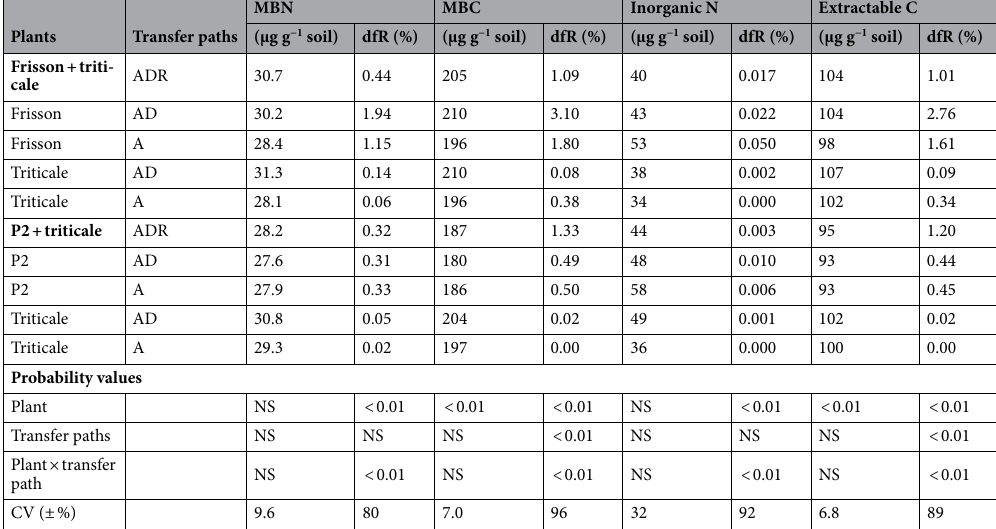
Table 5. Mean microbial biomass N (MBN) and C (MBC) contents, mean MBN and MBC percentages derived from rhizodeposition (dfR) in soil cropped with two pea varieties and triticale as intercrop after a 105-days greenhouse pot experiment; transfer paths: ADR = AMF, diffusion, and root contact between pea and intercrop; AD = AMF and diffusion; A = only AMF; CV = mean coefficient of variation between replicate pots (n = 6); probability values of a two-way ANOVA, using pea variety and transfer path treatment as factors, NS = not significant.